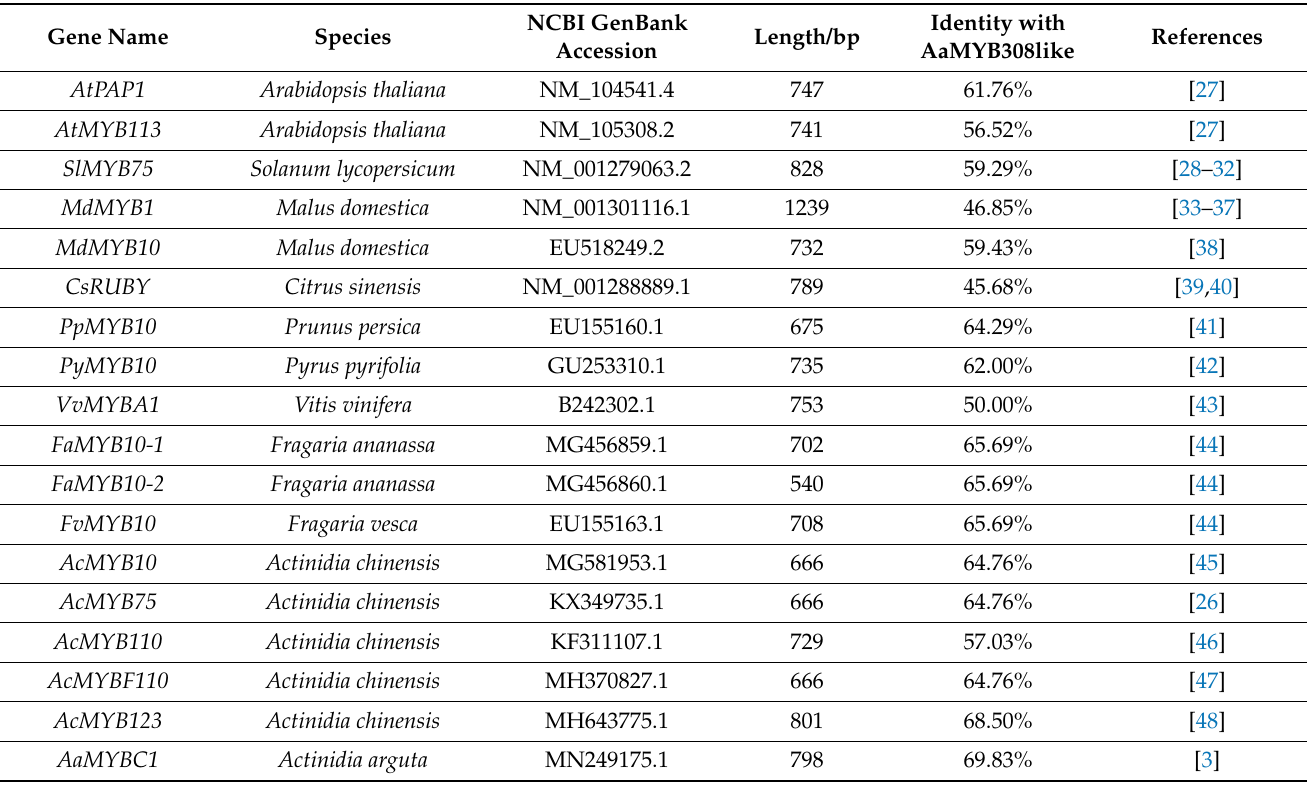
Table 3. Information for the anthocyanin-related MYB transcription factors in other species.